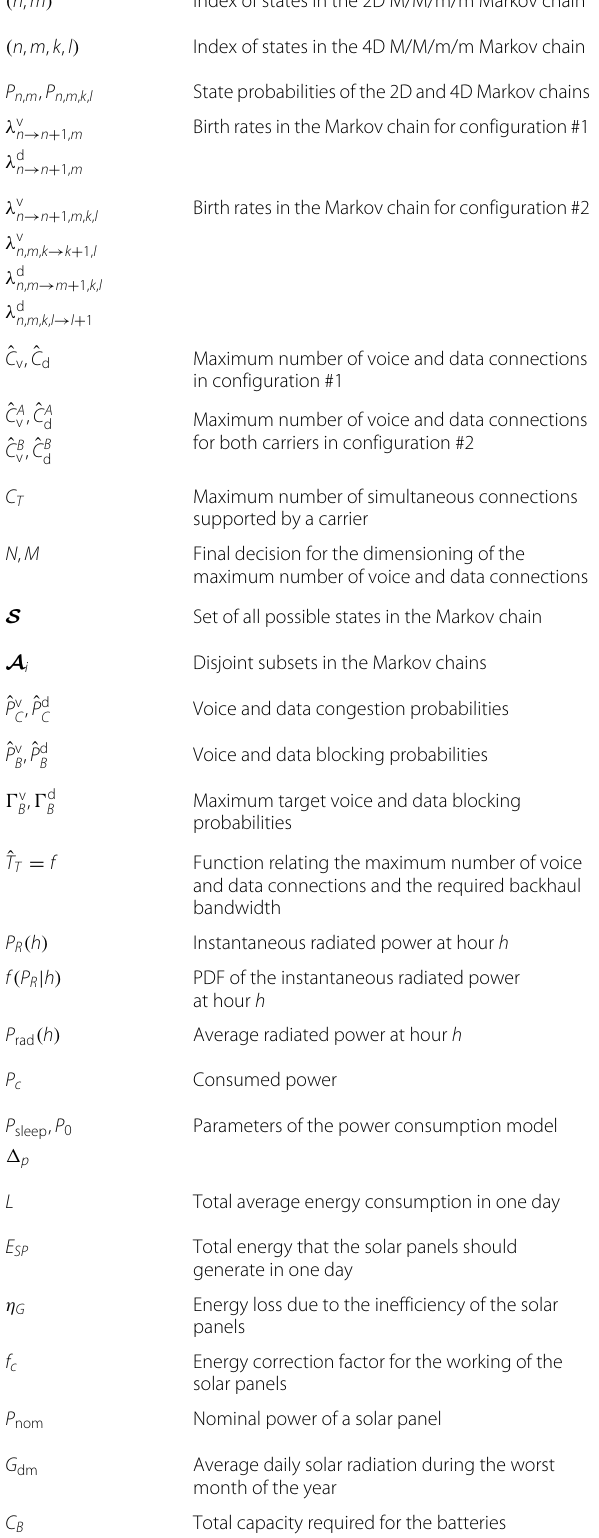
Table 6 List of parameters and symbols used in the paper